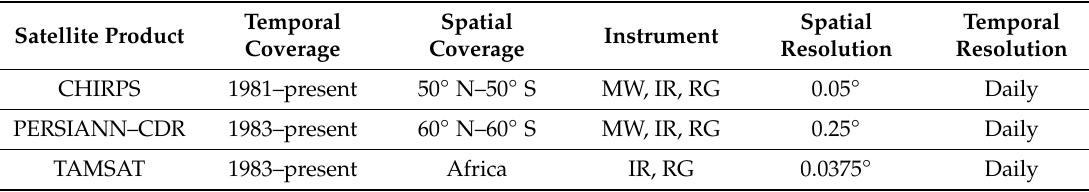
Table 2. Overview of satellite rainfall